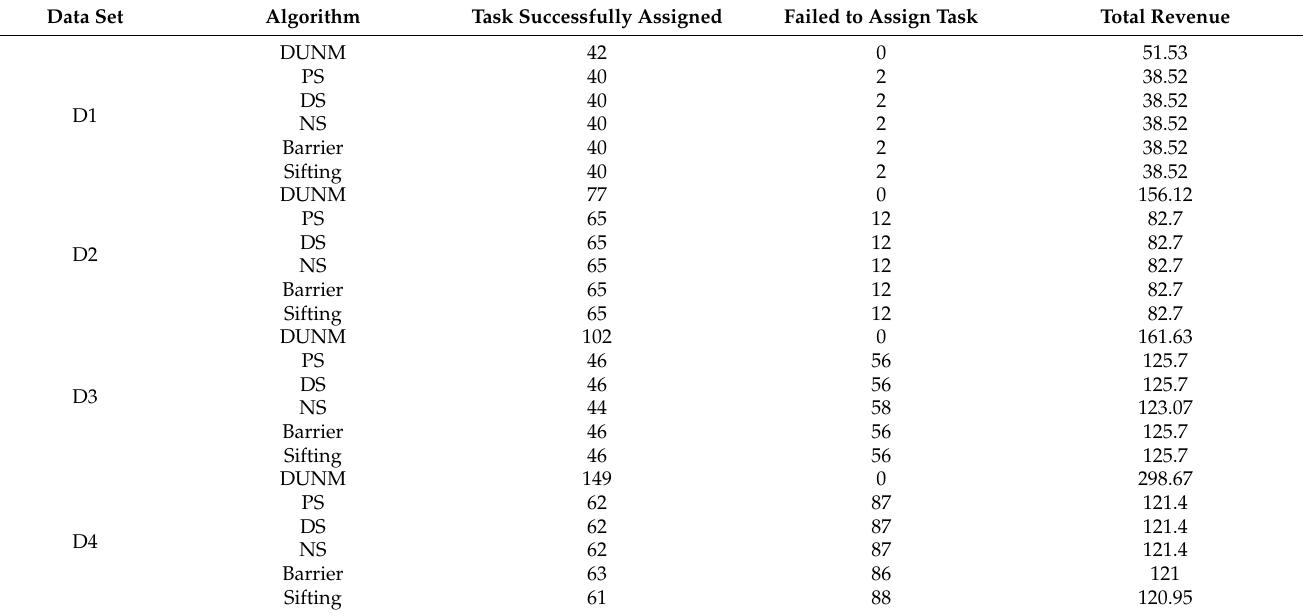
Table 3. Comparison of the total revenue of completing scheduling tasks between DUNM and the other five